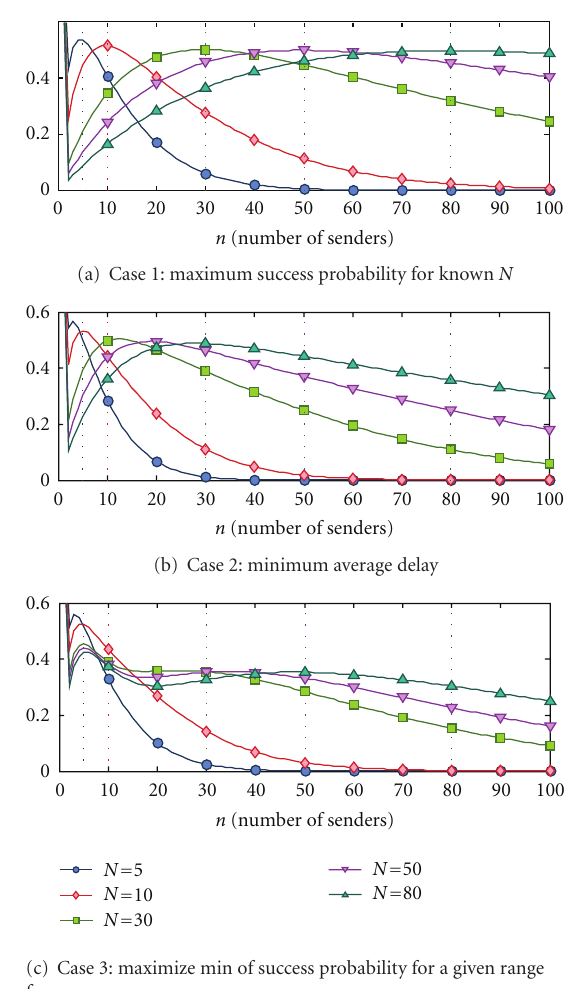
Figure 4: Probability of success of one Alert slot for di ff erent cases: case 1 (a) maximizing the success probability for a given N , case 2 (b) Minimizing the average number of time slots, case 3 (c) Maximizing minimum of success probability over 1 ≤ n ≤ N